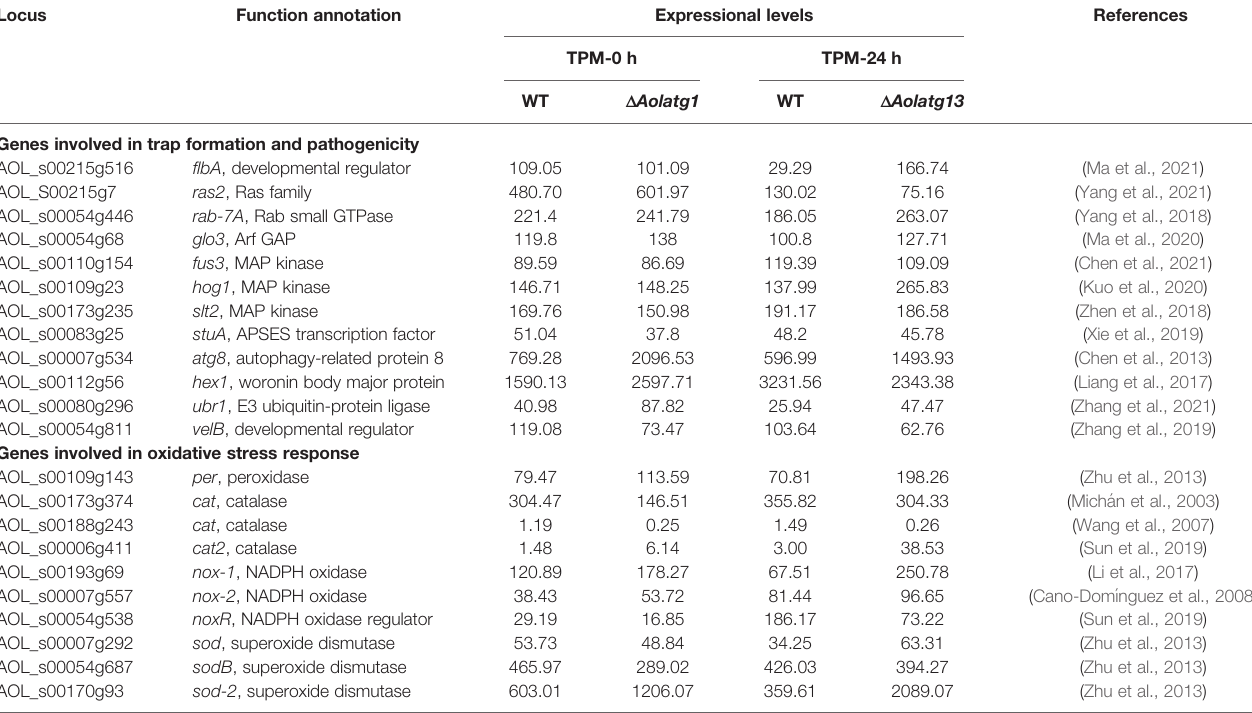
TABLE 1 | Transcriptional response to Aolatg1 deletion by the genes involved in trap formation and oxidative stress response in comparative transcriptome analysis. Locus Function